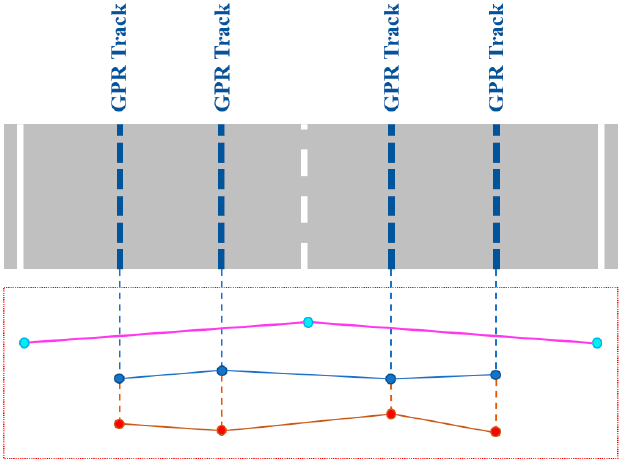
Figure 10. Implementation of GPR data in the parametric section.